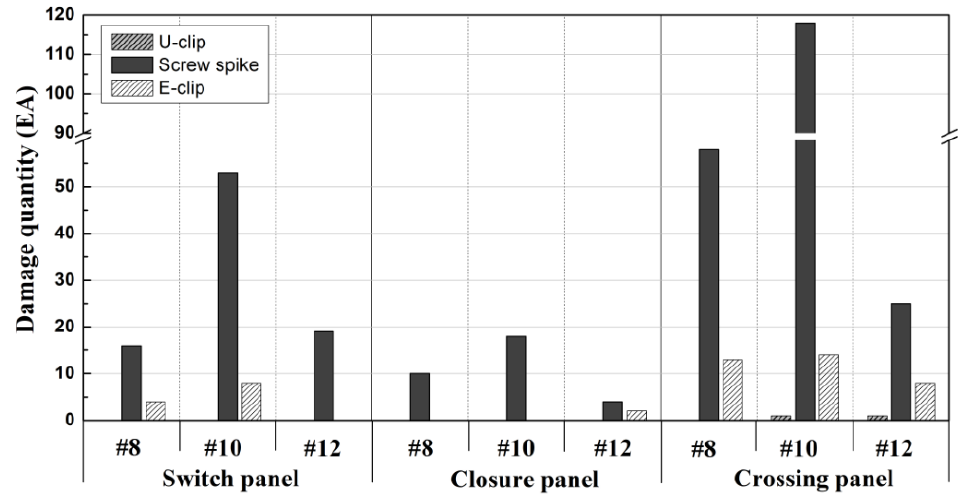
Figure 14. Damage status of fastening system.